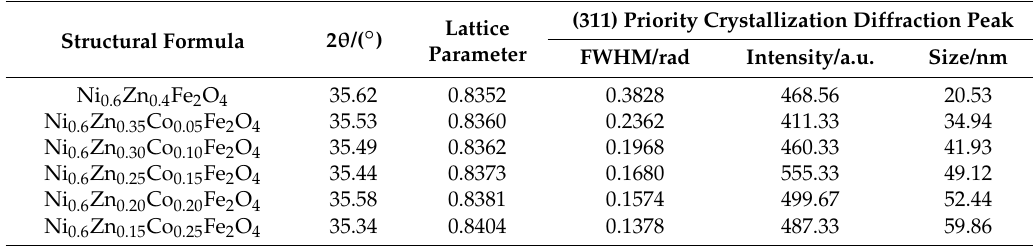
Figure 1. X-ray diffraction graph patterns of samples prepared with different Co 2+ content ( a ) and without Co 2+ content ( b ). Table 1. Composition and structure parameters of